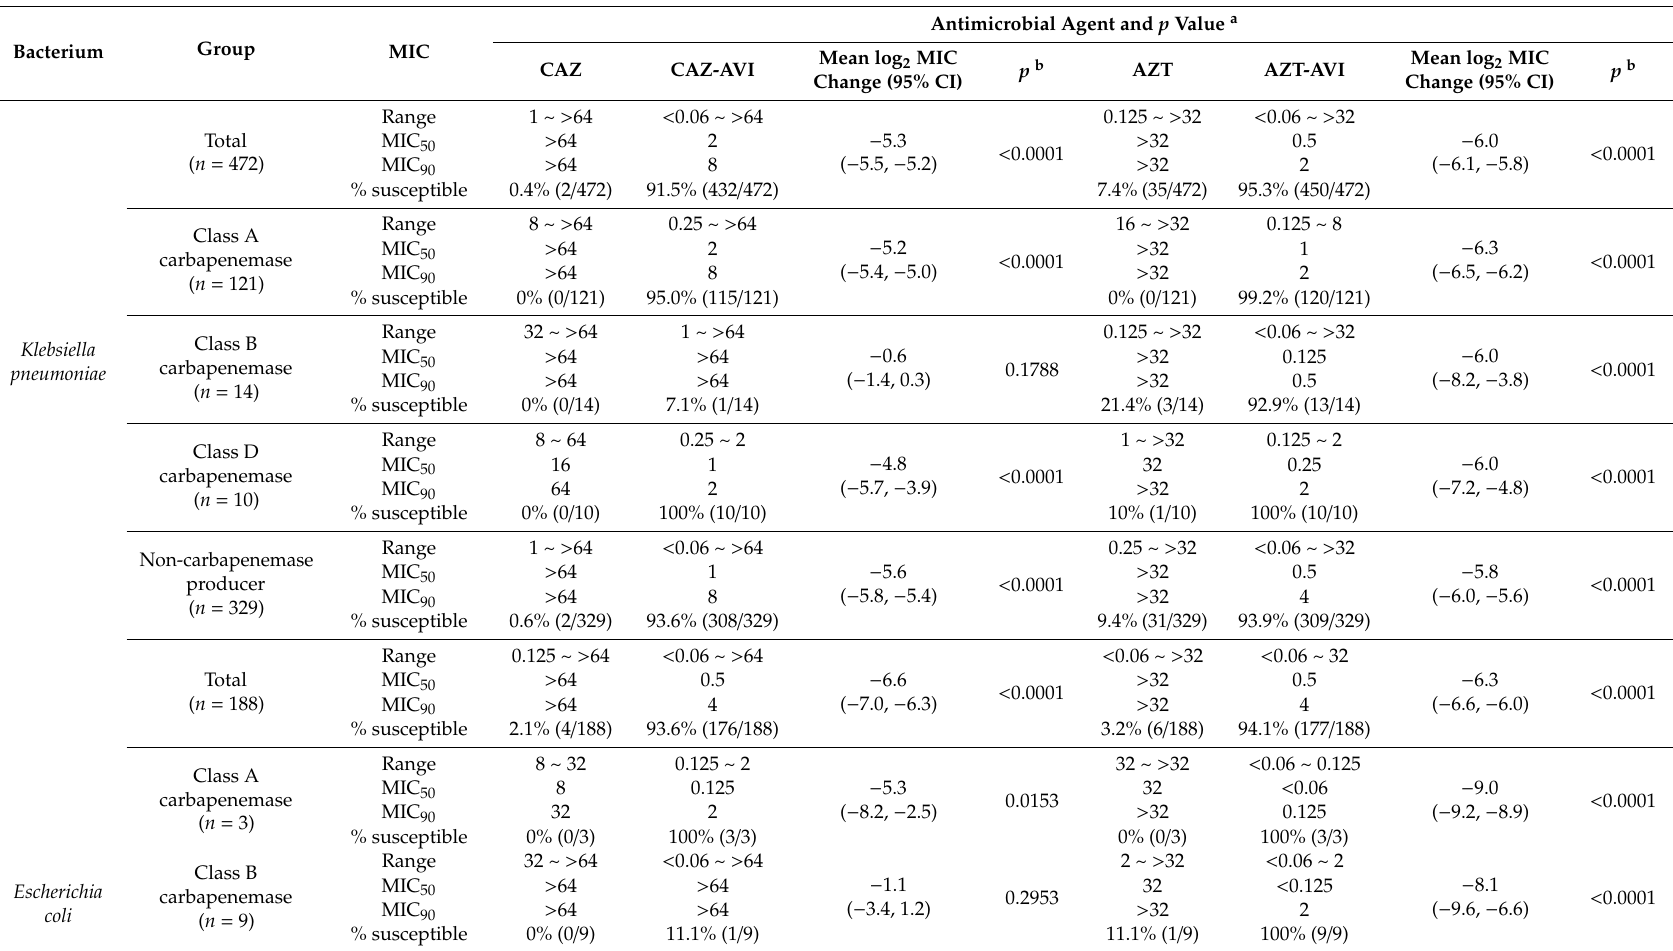
Table 1. Minimum inhibitory concentration (MIC) values for ceftazidime–avibactam and aztreonam–avibactam